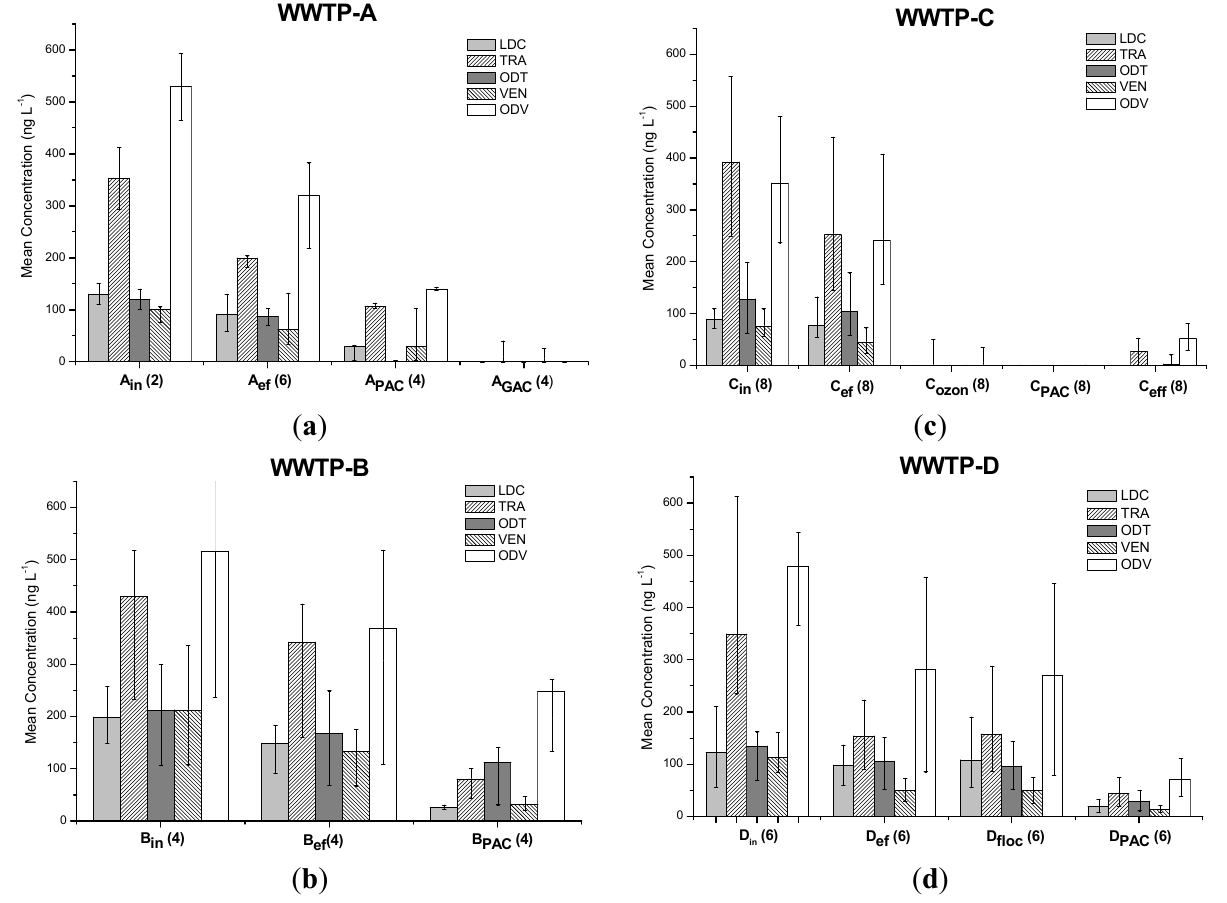
Figure 2. Average, maximum and minimum concentrations of target analytes along the ( d ) WWTP-D. Number of samples are given in